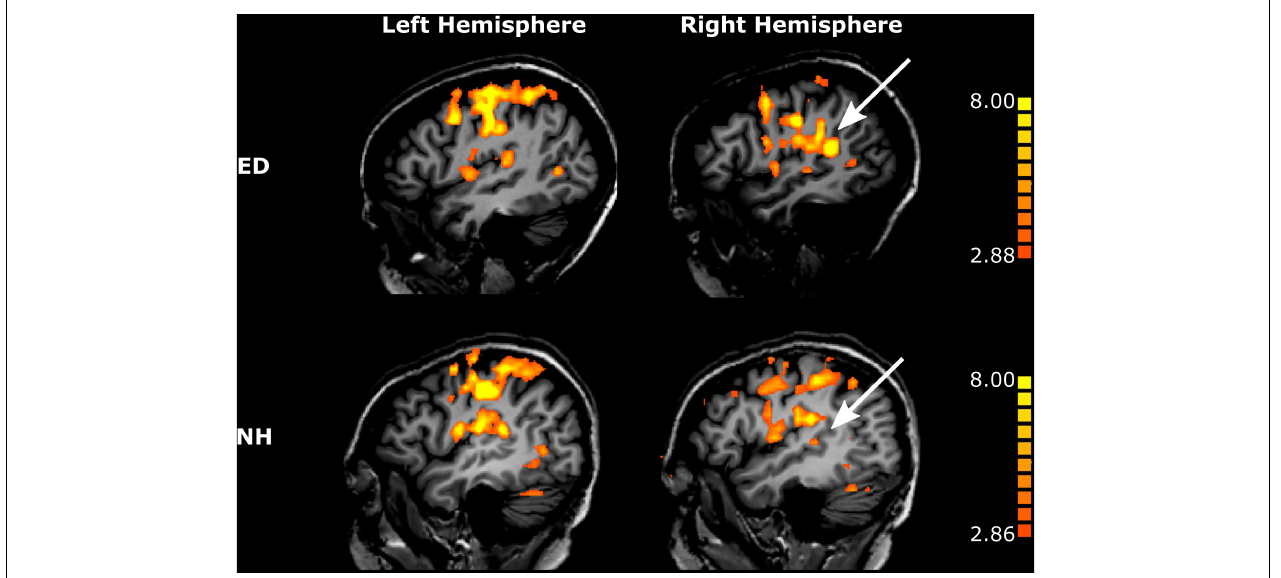
FIGURE 4 | Tactile motion activates right pSTS region to a greater extent in ED than in NH. Voxels with significant activation (qFDR < 0.05) are shown on sagittal sections in the left hemisphere (left column) and in the right hemisphere (right column) for a representative ED (top row) and NH participant (bottom row). White arrows point to right pSTS region.